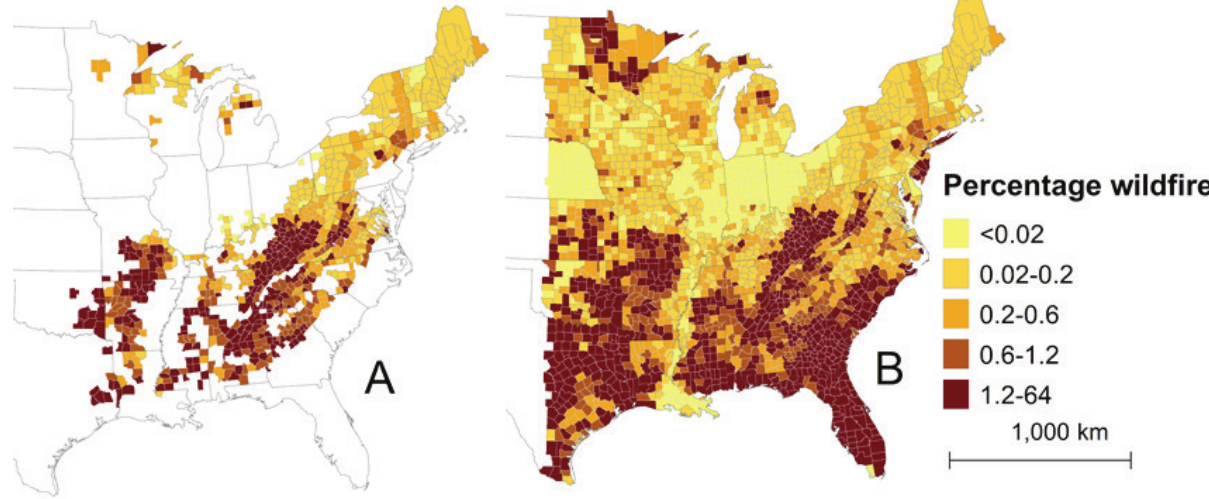
Figure 4. Percentage wildfire area (fire occurrence database; Short 2017) by county in eastern forests (A) and the eastern United States (B).